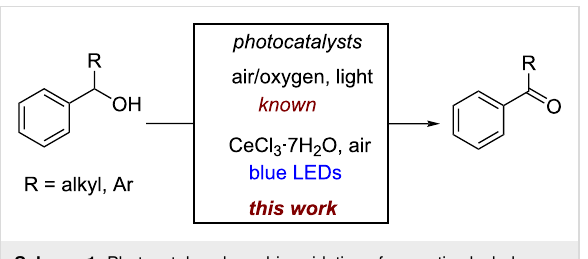
Scheme 1: Photocatalyzed aerobic oxidation of aromatic alcohols.